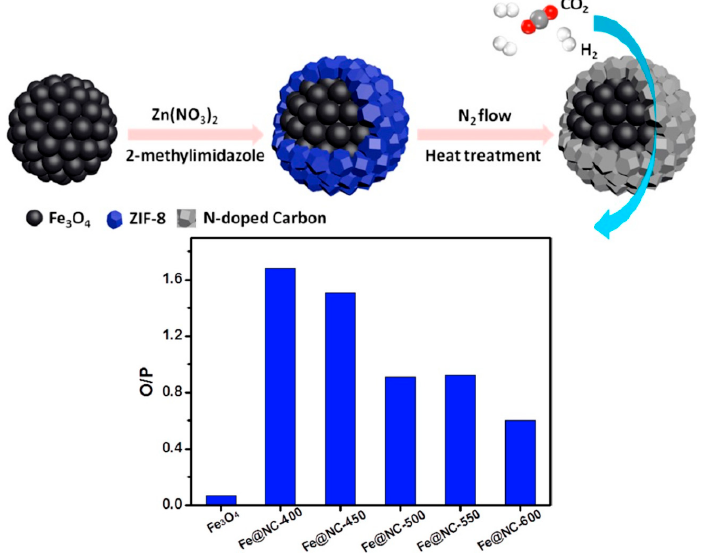
Figure 24. Schematic illustration of the formation of Fe@NC catalysts and the reaction for CO 2 hydrogenation. Adapted with permission from ref. [36]. Copyright 2019 American Chemical Society.